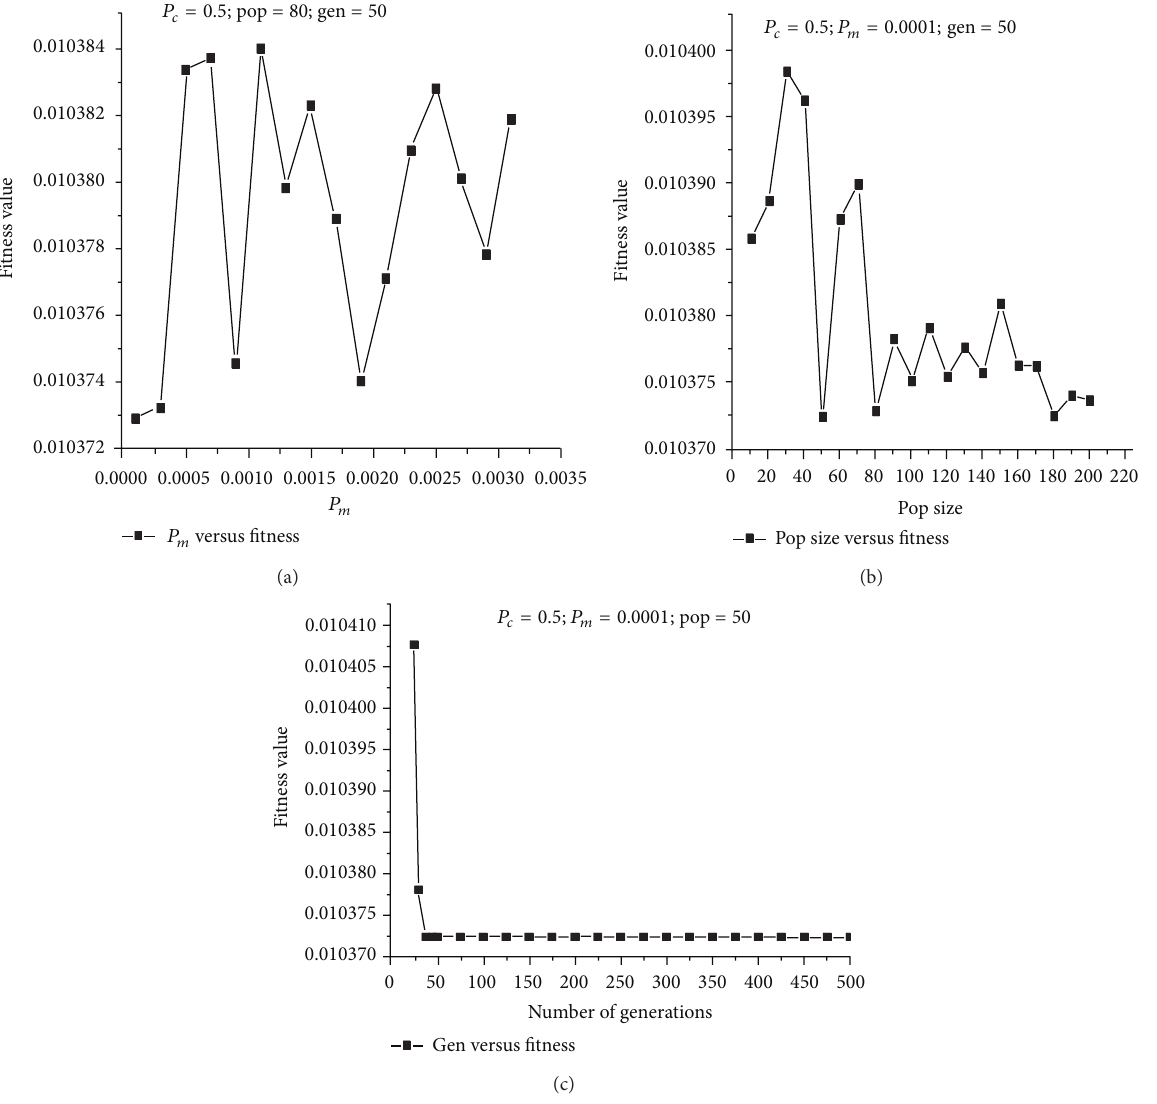
Figure 2: Results of parametric study. (a) Probability of mutation versus fitness, (b) population size versus fitness, (c) maximum number of generations versus